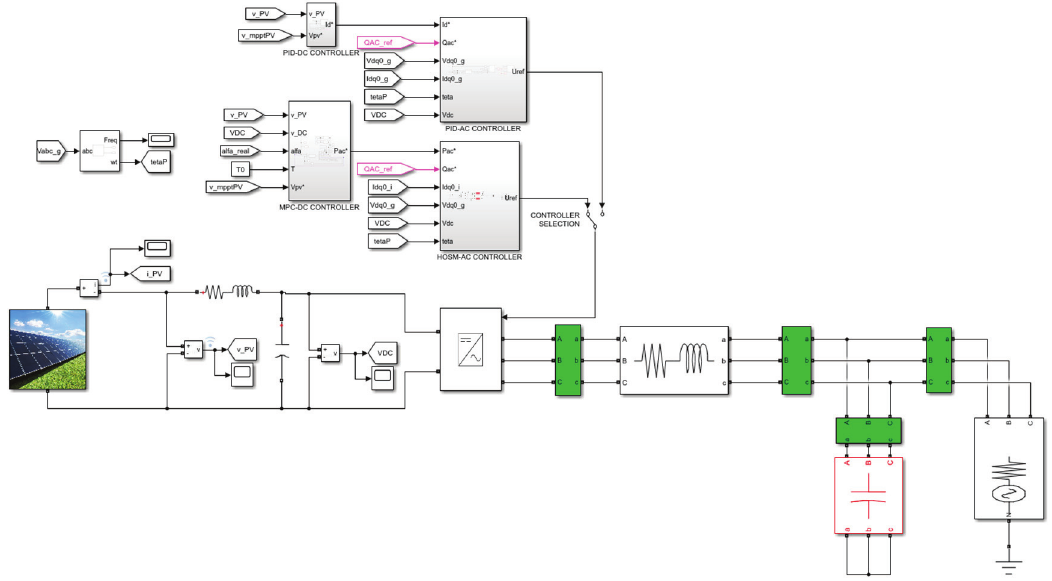
Figure 4. PV unit implemented in MATLAB and Simulink environment.